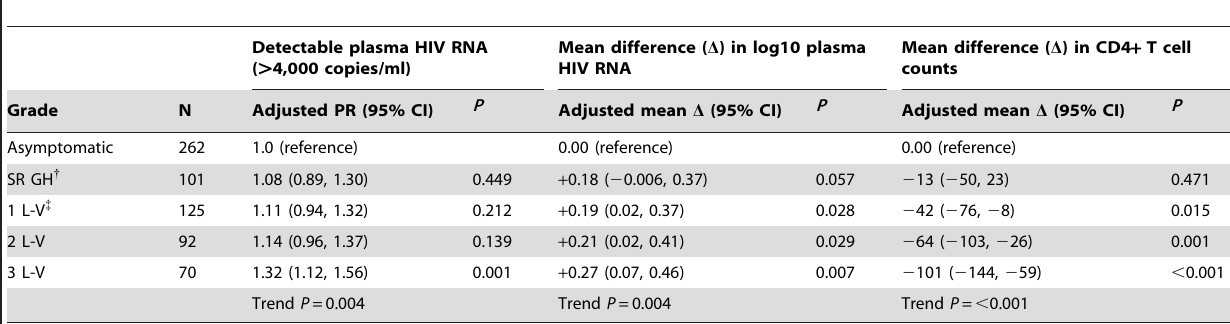
Table 5. Adjusted* prevalence risk ratios (PRs) of detectable plasma HIV RNA and mean differences in plasma HIV RNA and CD4 + T cell counts (from the cross-sectional log binomial and linear regression models at the 3 rd visit) by degree of HSV-2 clinical activity.